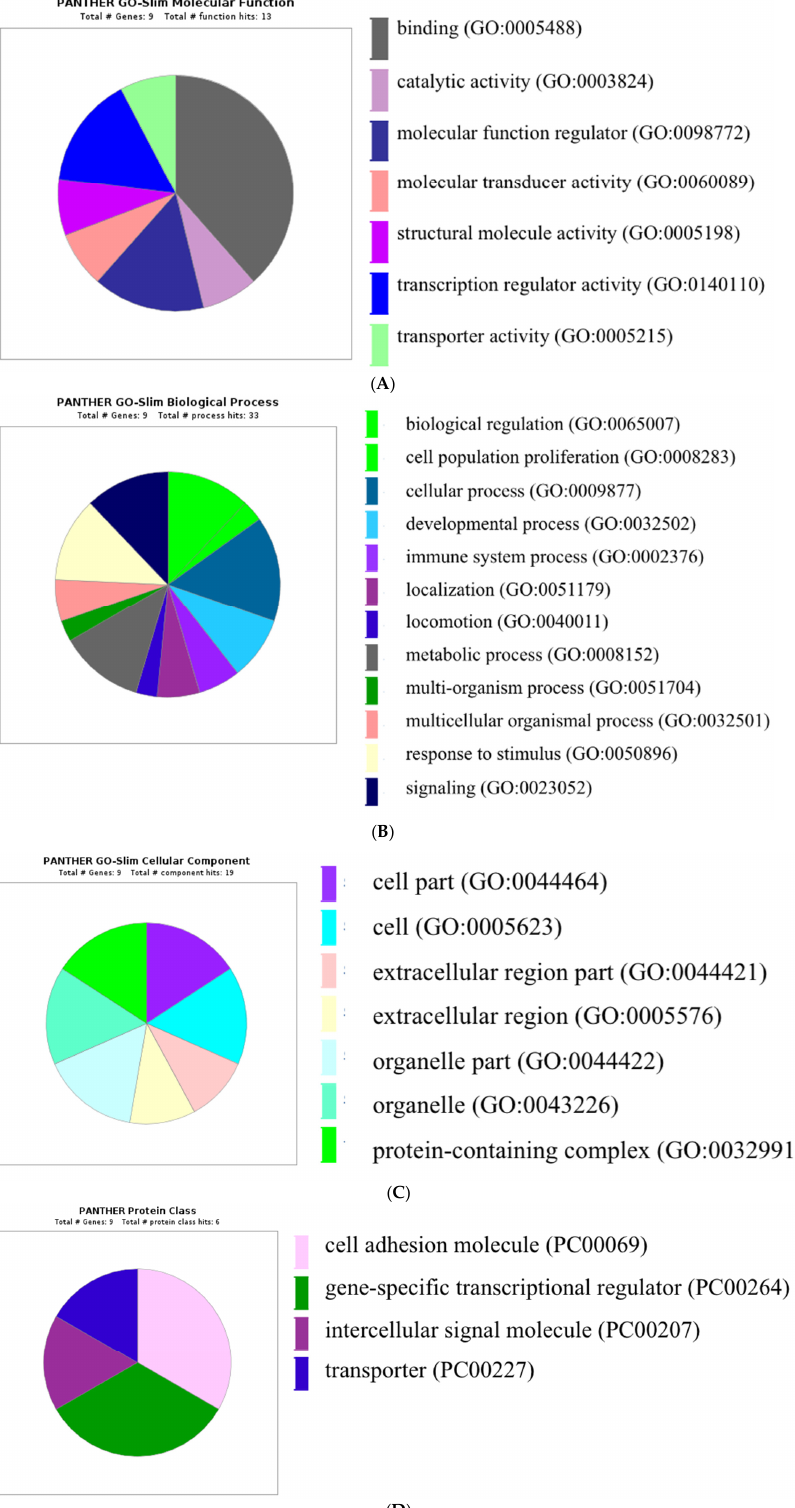
Figure 6. Gene ontology (GO) processes of target proteins depicting ( A ) Molecular functions; ( B ) Bio- logical process; ( C ) Cellular component and ( D ) Protein class